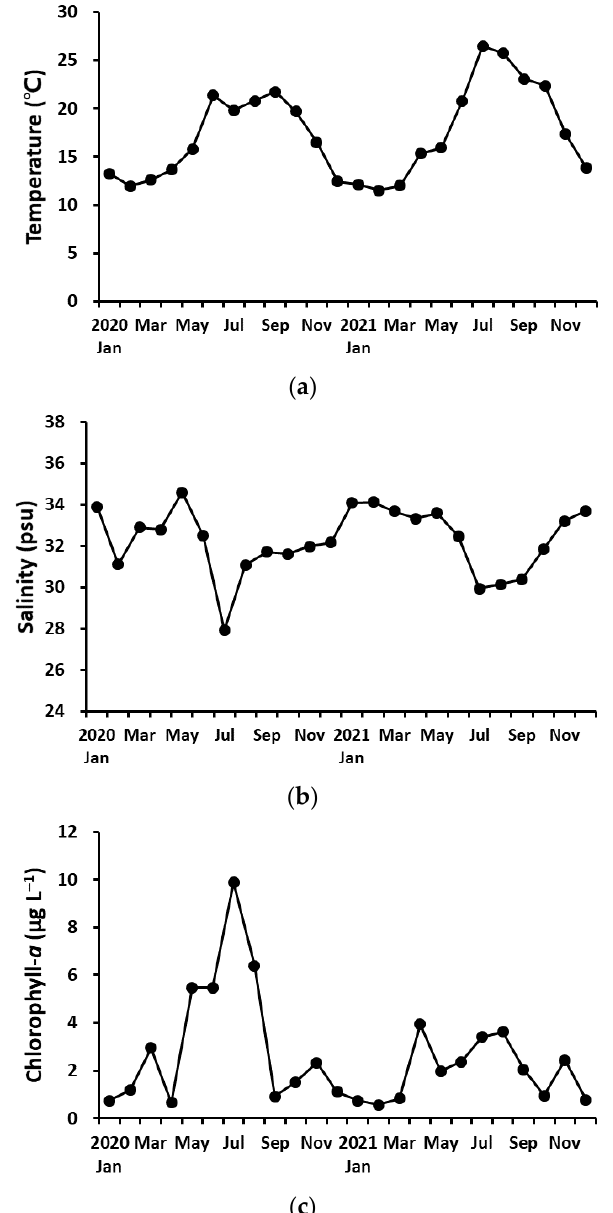
Figure 2. Variations of water temperature ( a ), salinity ( b ), and chlorophyll- a concentration ( c ).